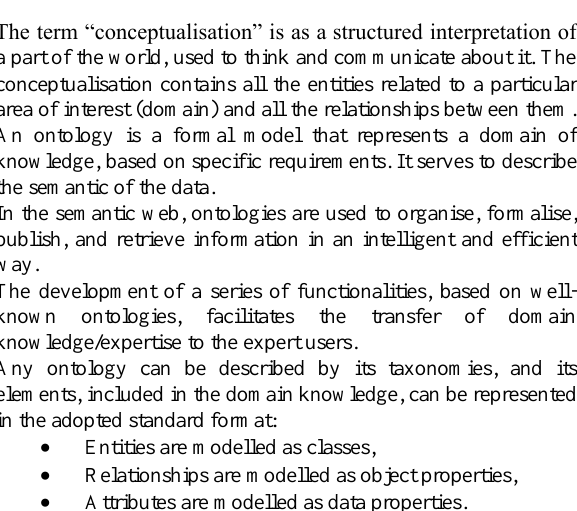
Figure 5. Workflow diagram for the creation and use of domain